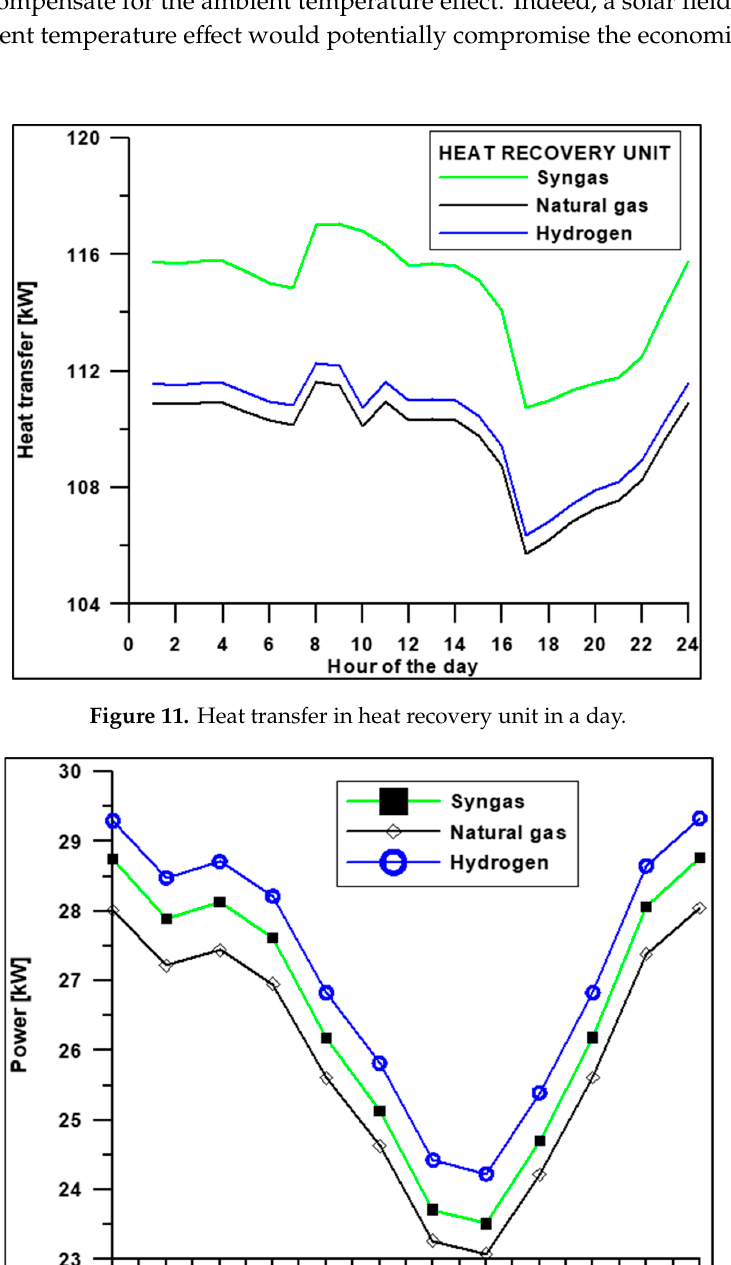
Figure 10. Input fuel power versus day hours.